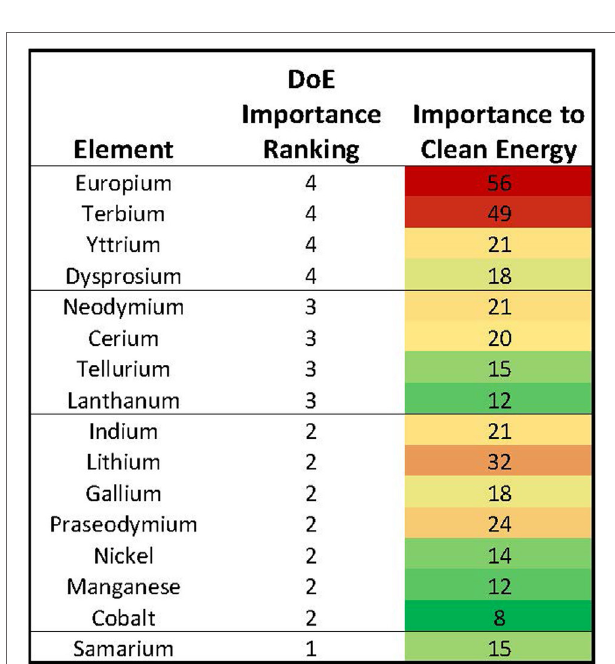
FigUre 7 | To determine the importance rankings for clean energy, clusters were weighted using a weight reflecting their relevance to clean energy, as shown here. Weights were determined using a “clean energy” glossary, manually created by the analysts. When applied, the revised plant “bulb” cluster has a low clean energy weight, while the revised LED “bulb” has a high clean energy weight.